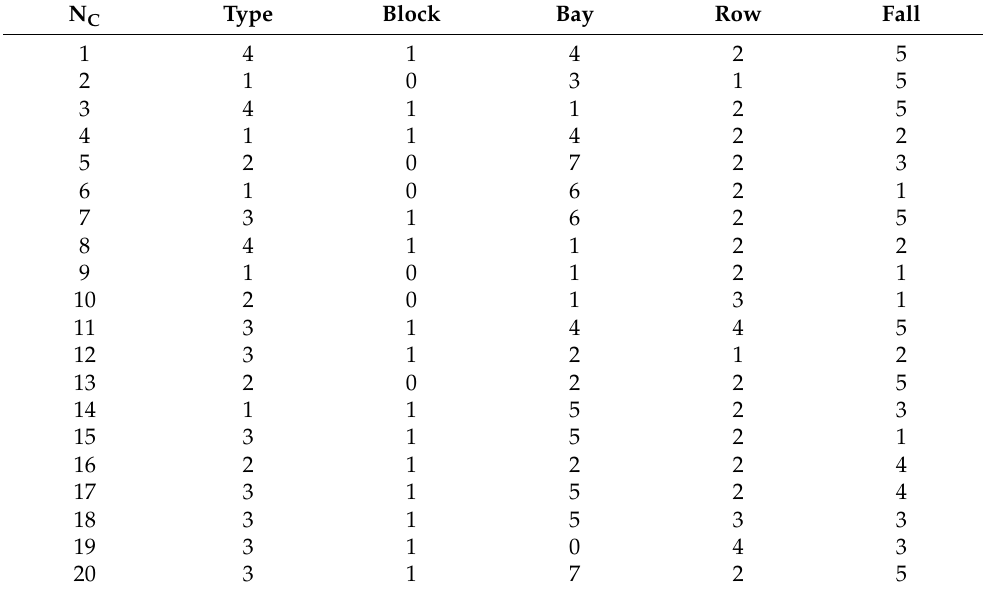
Table A1. Numerical example: general tasks information.